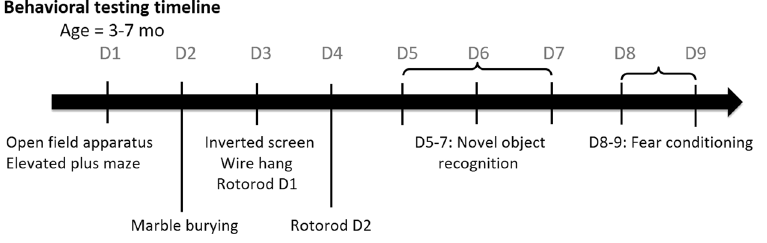
Figure 1. Timeline for behavioral battery of activity, anxiety, motor, and learning and memory